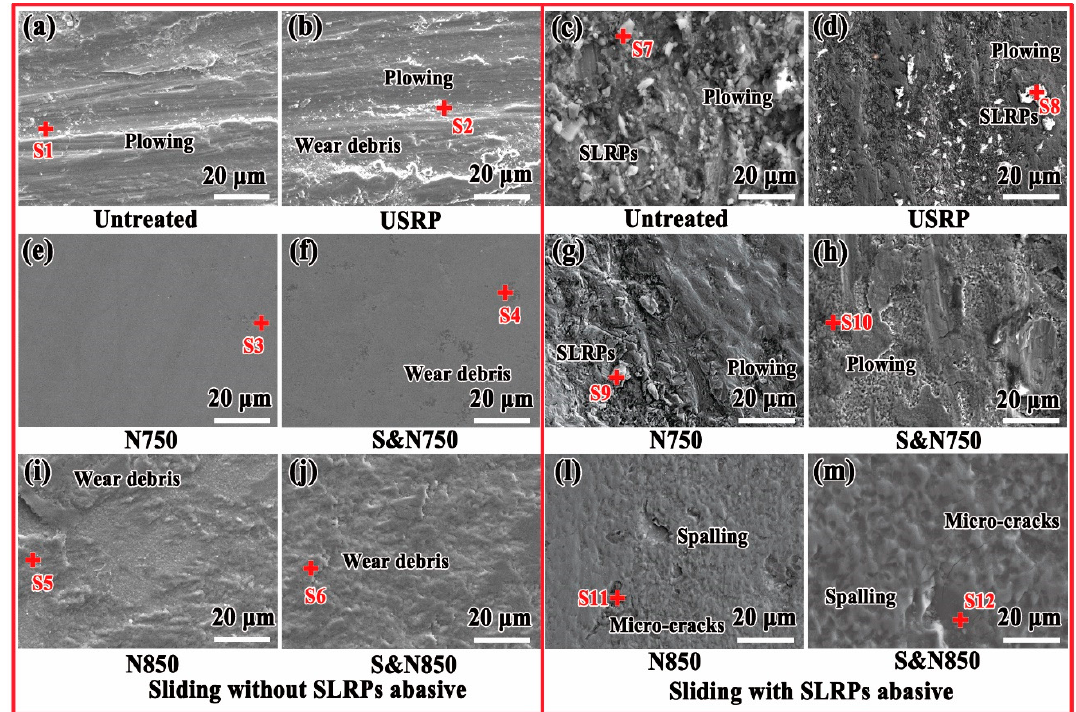
Figure 12. Typical secondary electron SEM image showing the surface morphology of the worn surface on the Ti treated by USRP pre-treatment and plasma nitriding sliding ( a , b , e , f , i and j ) without and ( c , d , g , h , l and m ) with abrasive SLRPs. Table 4. EDS analysis results show the elementary composition of wear debris on a worn surface.